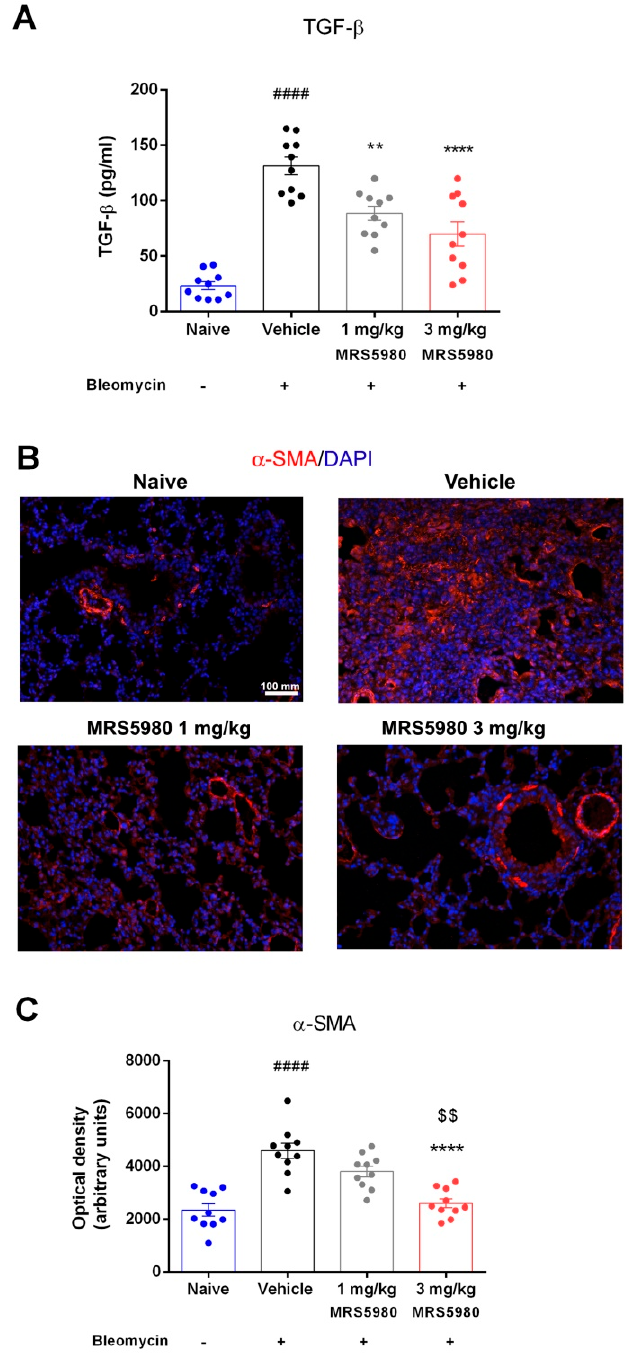
Figure 4. ( A ) Assessment of TGF- β production, a pro-fibrotic marker. Values are expressed as pg/ μ L. ( B ) Determination of fibroblast differentiation into myofibroblast. Lung tissue sections were labelled by immunofluorescence staining with α -smooth muscle actin ( α -SMA) antibody (red) and DAPI (blue) to counterstain the nuclei (magnification 20 × ). Images show the inhibition of α -SMA expression, a marker of the transformation of fibroblasts into myofibroblasts. ( C ) Densitometric data are reported as relative optical density (OD) in each experimental group (naïve 2352 ± 231 OD, vehicle 4599 ± 287 OD, 1 mg/kg 3808 ± 204 OD and 3 mg/kg 2064 ± 168 OD). Data are mean ± S.E.M., n = 10 animals per group. #### p < 0.0001 vs. naïve, ** p < 0.01 **** p < 0.0001 vs. vehicle and $$ p < 0.01 vs. 1